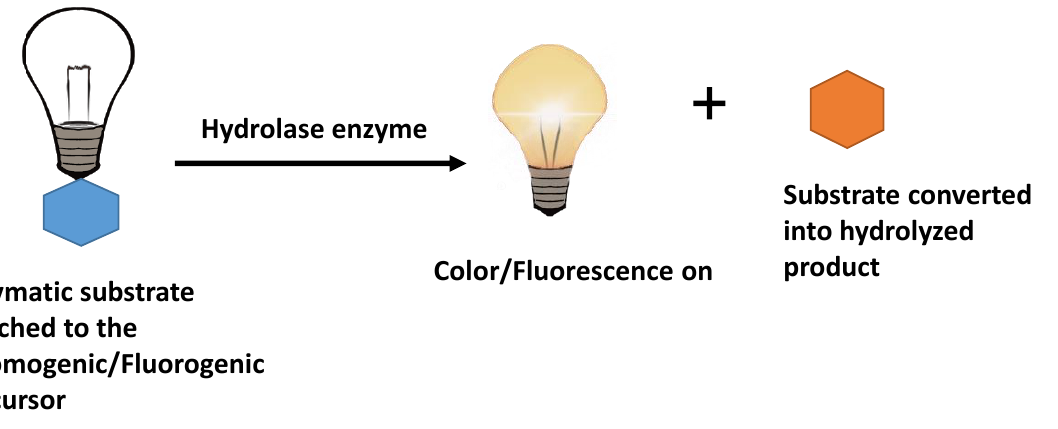
Figure 1. Schematic representation of enzymatic reaction in chromogenic/fluorogenic media. Here, enzyme substrate is linked to chromogenic/fluorogenic precursor. In the presence of pathogen in food sample, an enzymatic cleavage occurs that releases a detectable signal.